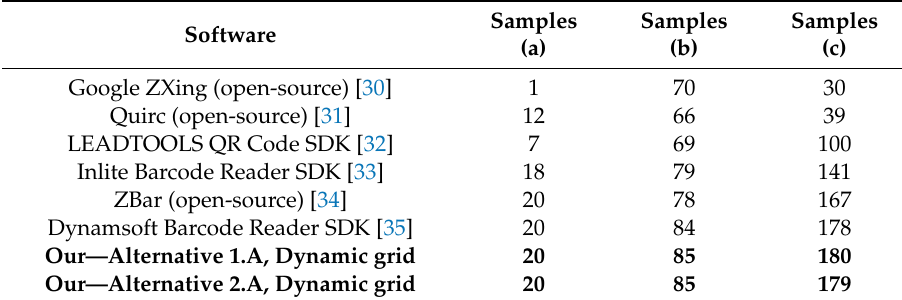
Table 1. Our results compared with competitive